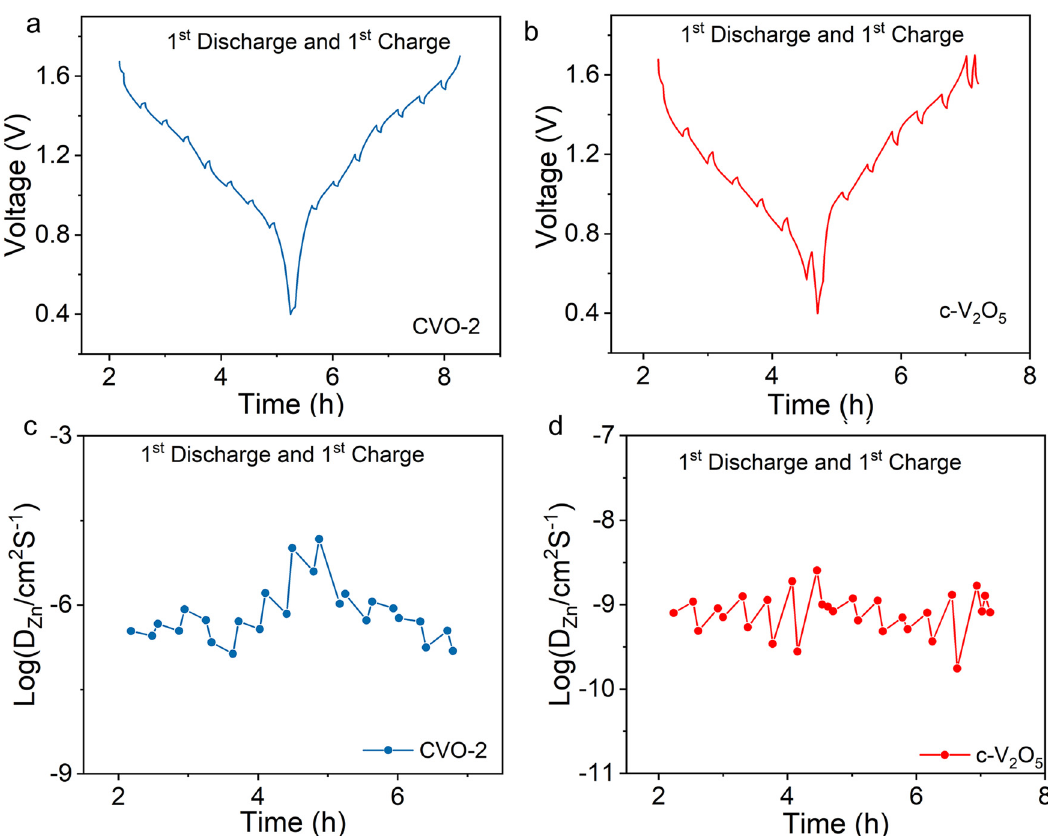
Figure 6: The charge/discharge GITT curves of ( a ) CVO - 2 and ( b ) c - V 2 O 5 . The calculated chemical di ff usion coe ffi cient for Zn 2 + of ( c ) CVO - 2 and ( d ) c - V 2 O 5